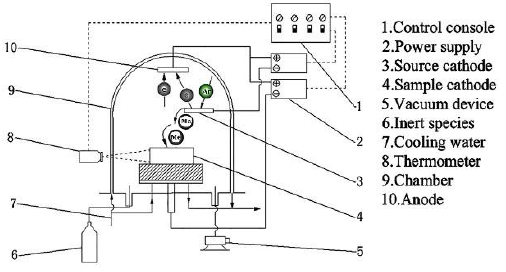
Figure 1. Schematic diagram of the double glow plasma surface alloying technique. Table 2. Process parameters of plasma surface